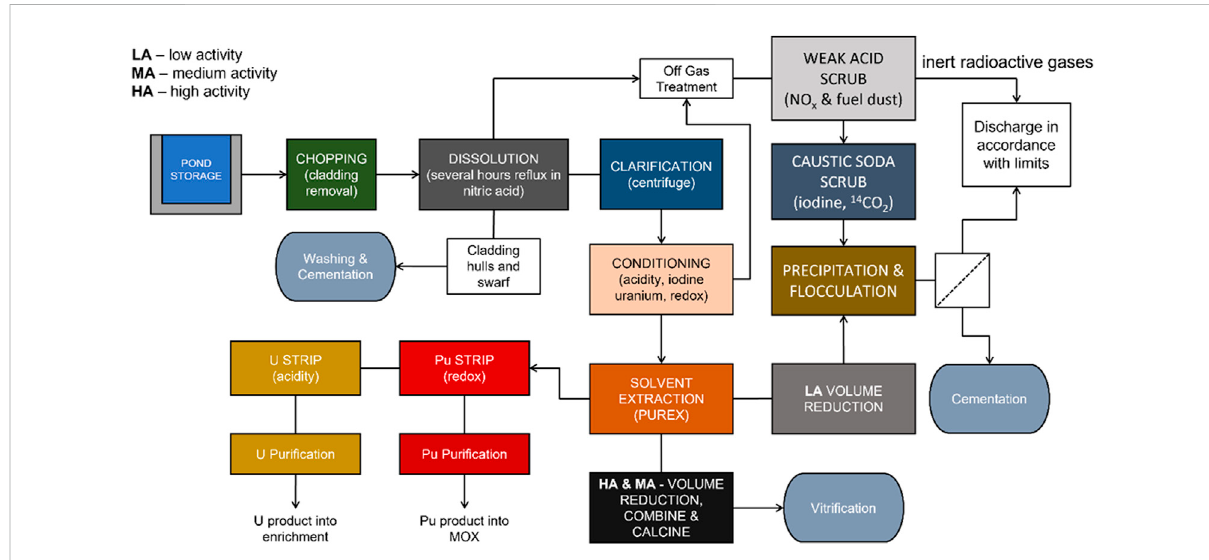
FIGURE 1 Generic UNF reprocessing scheme for a partially closed nuclear fuel cycle based upon an early split Plutonium and Uranium Redox Extraction (PUREX) separation and a simpli fi ed back end of Thermal Oxide Reprocessing Plant (THORP) (Wilson,